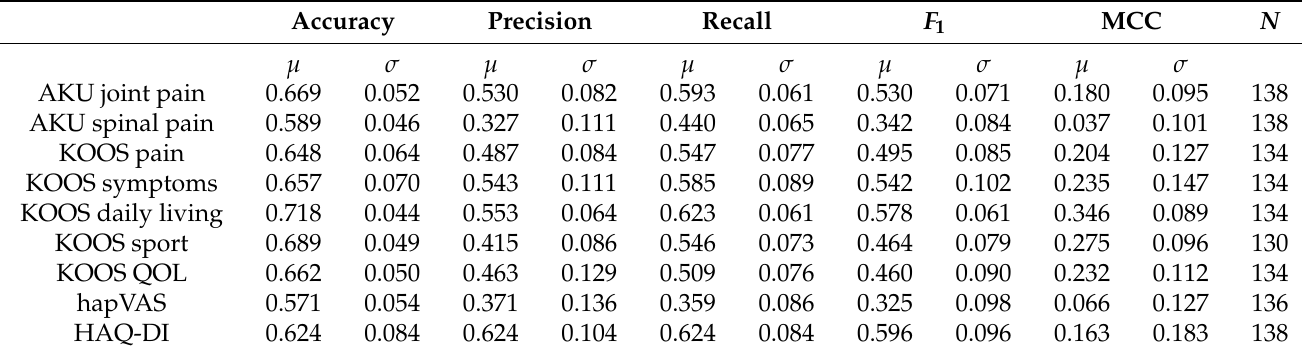
Table 2. QoL scores prediction with RF; the last column represents the number of records available for that particular QoL score.